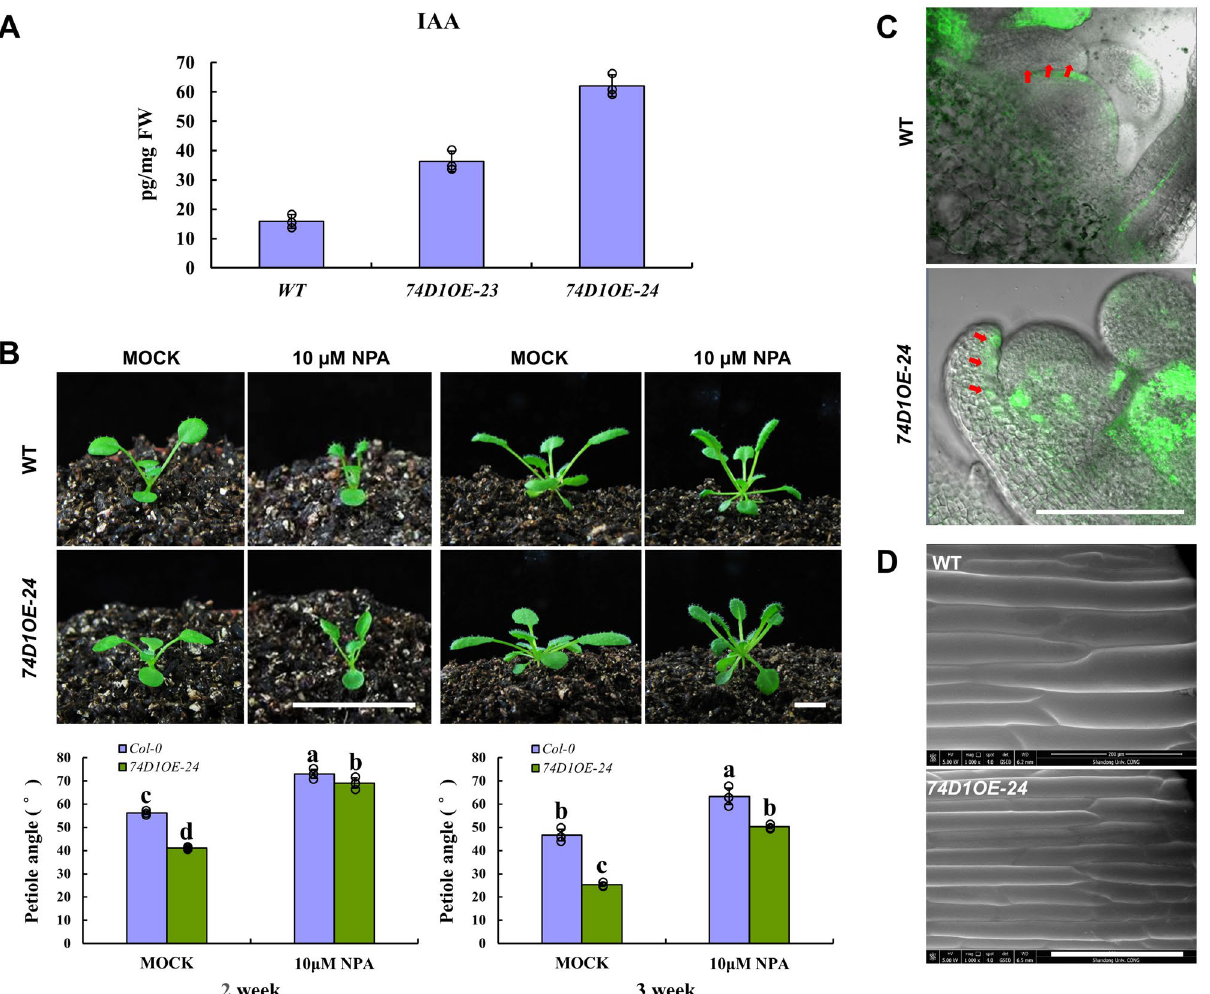
Figure 7. The analyses of IAA level and cell shape in leave petioles of UGT74D1 OE lines. ( A ) The measurement of IAA level. ( B ) The response of leaf petiole angle to auxin transport inhibitor NPA. Scale bar = 1 cm. At least 15 plants were tested within one replicate. The statistical significance of the difference was confirmed by ANOVA at α = 0.05 level. Error bars indicate SD from triplicate experiments. ( C ) Auxin signal distribution indicated by GFP fluorescence in leaf primordia. Scale bar = 100 μm. ( D ) Cell shape of leaf petioles. Scale bar = 200